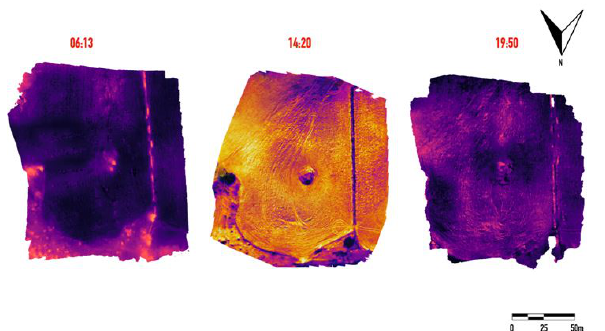
Figure 15. Comparison of thermal orthophotos obtained from missions carried out at different times of the day (Monte Kassar, Castronovo di Sicilia, PA,